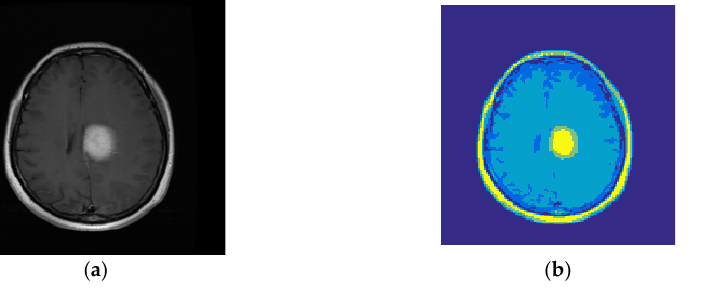
Figure 3. Result of image segmentation by the proposed method ( a ) A sample MRI from BRATS2014 ( b ) Result of segmentation.